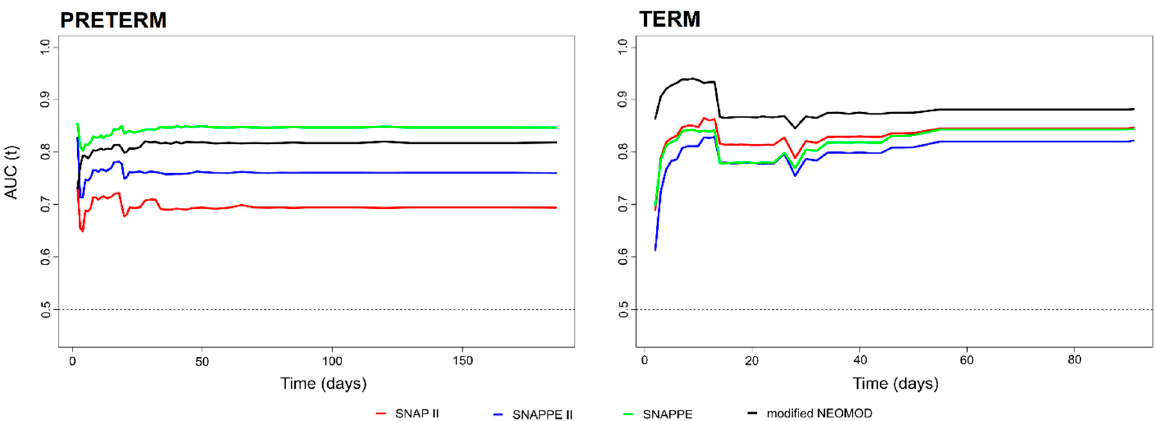
Figure 4. Performance of the four indexes in preterm and term neonates. SNAP II, red line; SNAPE II, blue line; SNAPPE, green line; modified NEOMOD, black line. The dotted line (of AUC = 0.5) means the model has no discrimination capacity.